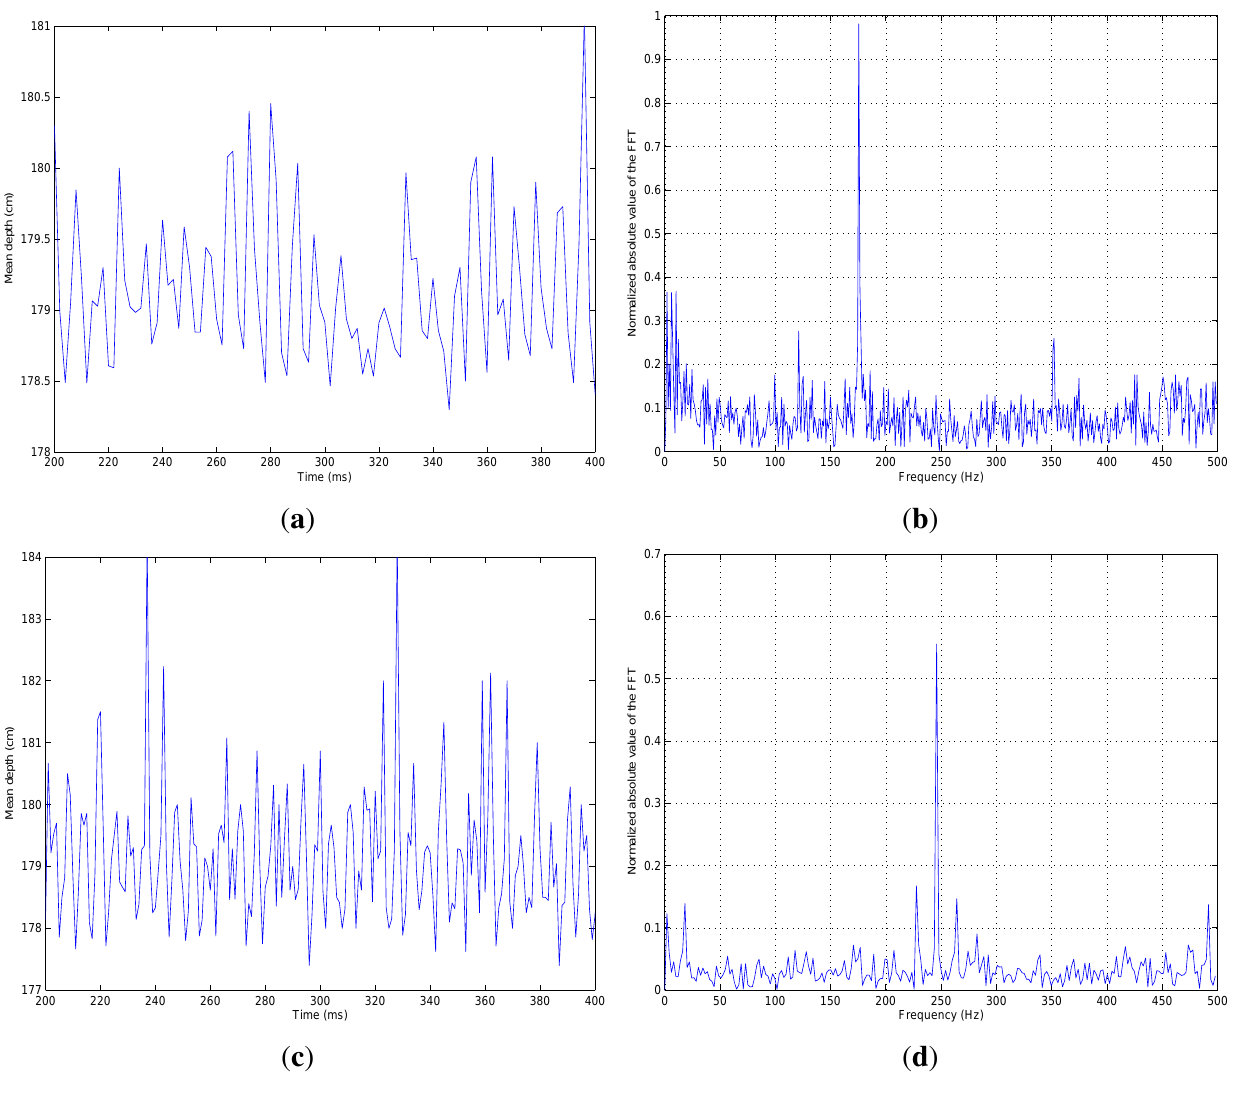
Figure 11. Mean depth and FFT for 175 and 240 rps helix movement. SCD processing. ( a ) Average depth for 175 rps; ( b ) FFT for 175 rps; ( c ) Average depth for 240 rps; ( d ) FFT for 240